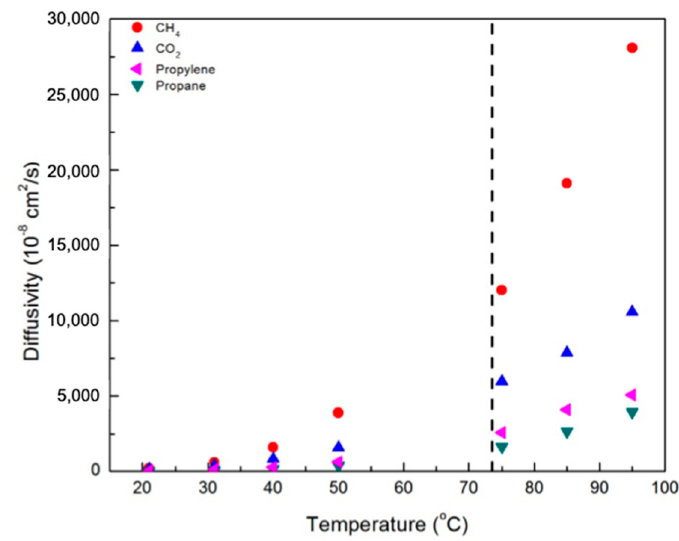
Figure 7. Diffusivity of various gases in the CNBPh75_2.5 membrane (2.5% crosslinker) in the nematic and isotropic phases. The dashed line indicates the nematic–isotropic transition temperature. An expanded view of the nematic region is given in the supporting information.